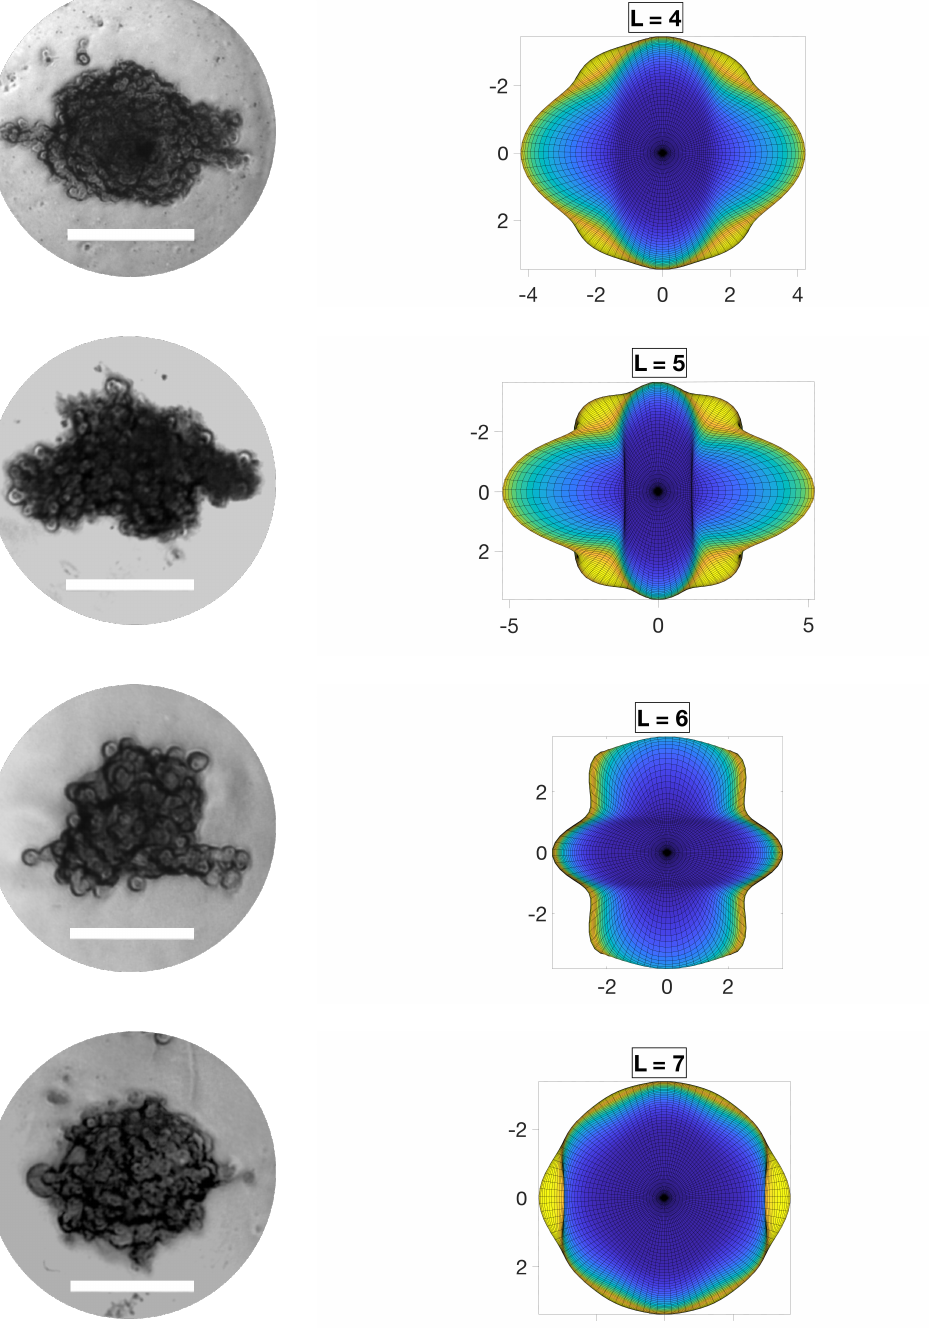
Figure 5. Asymmetric configurations of in vitro human glioblastoma (hGB) spheroids ( left column ) compared with the similar configurations of maximal asymmetric modes predicted by the model ( right column ). Nearly spherical tumors with no heterogeneity in their cell population were provided with constant concentration of nutrients C ∞ at their boundary to resemble a symmetric environmental condition. Scale bars are 200 µ